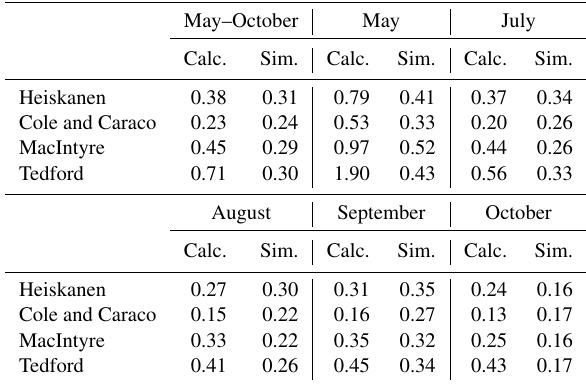
Table 3. Total and monthly averages of simulated and calculated CO 2 fluxes (µmolm − 2 s − 1 ) in May–October 2013 obtained with different gas exchange models. Only the days with available mea- surement data are included in the averaging of the simulated fluxes. Monthly values for June are excluded because measurement data were available only for